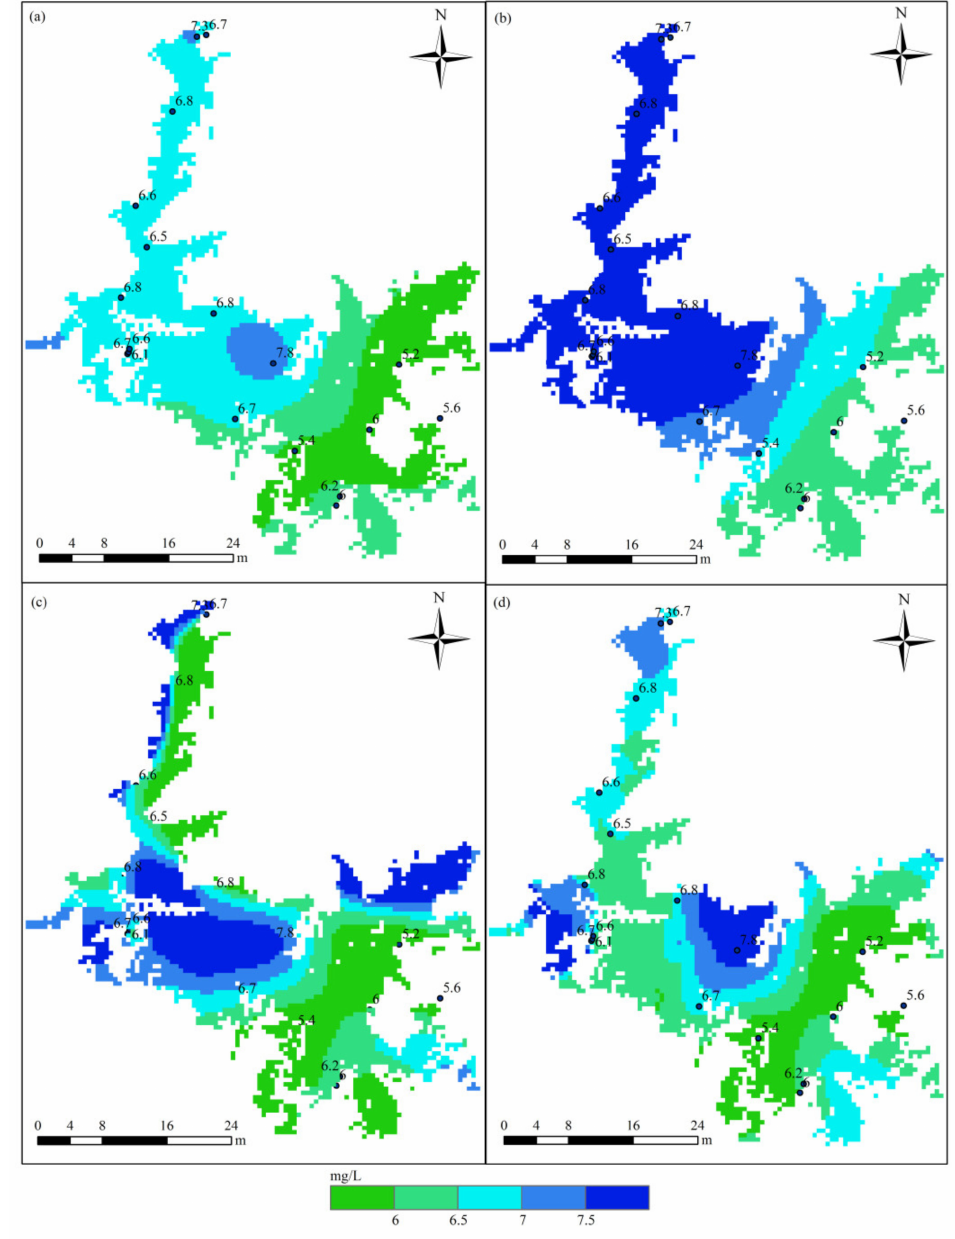
Figure 5. Spatial distribution of DO in Poyang Lake in August using different methods: ( a ) cokriging; ( b ) the SVM; ( c ) HASM; ( d )